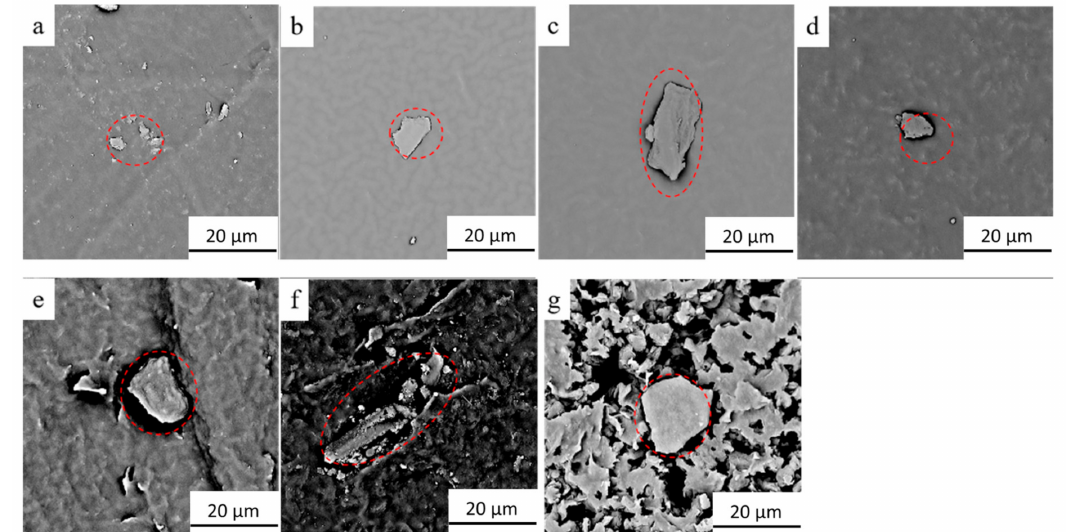
Figure 4. SEM images of surface morphology of the composite films prepared with the initial TPU concentration of 20 wt% and the graphene mass content of 0.3 wt% ( a ), 0.6 wt% ( b ), 2.0 wt% ( c ), 3.0 wt% ( d ), 4.0 wt% ( e ), 5.0 wt% ( f ), and 7.0 wt% ( g ), respectively.